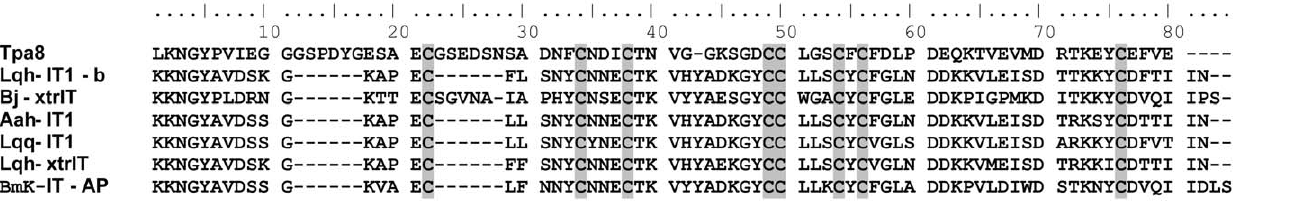
Figure 2. Multiple sequence alignment of Tpa8 with other anti-insect b excitatory NaScTxs from the Old World. Tpa8 putative toxin from T. pachyurus , LqhIT1b from Leirus quinquestriatus hebraeus , Bj-xtrIT from Buthotus judaicus , AahIT1 from Androctonus australis , LqqIT1 from Leiurus q.quinquestriatus , Lqh-xtrIT from Leirus q. hebraeus and BmK IT-AP from Mesobuthus martensii . doi:10.1371/journal.pone.0030478.g002 PLoS ONE |